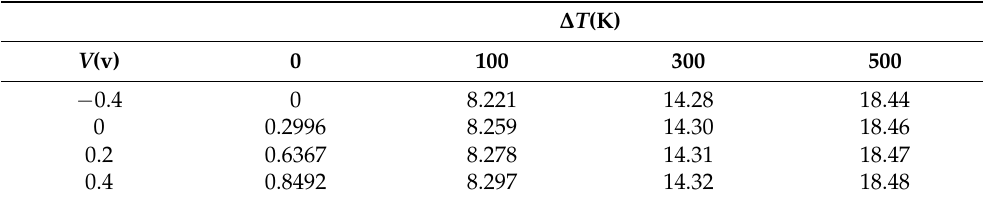
Table 5. Fundamental frequency values of vibration under different voltage values V and temperature